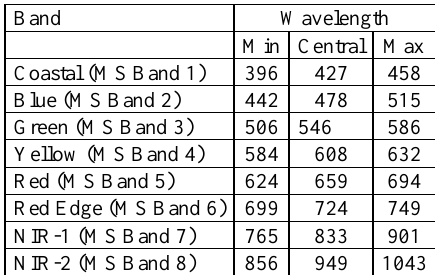
Table 1. Worldview-2 band